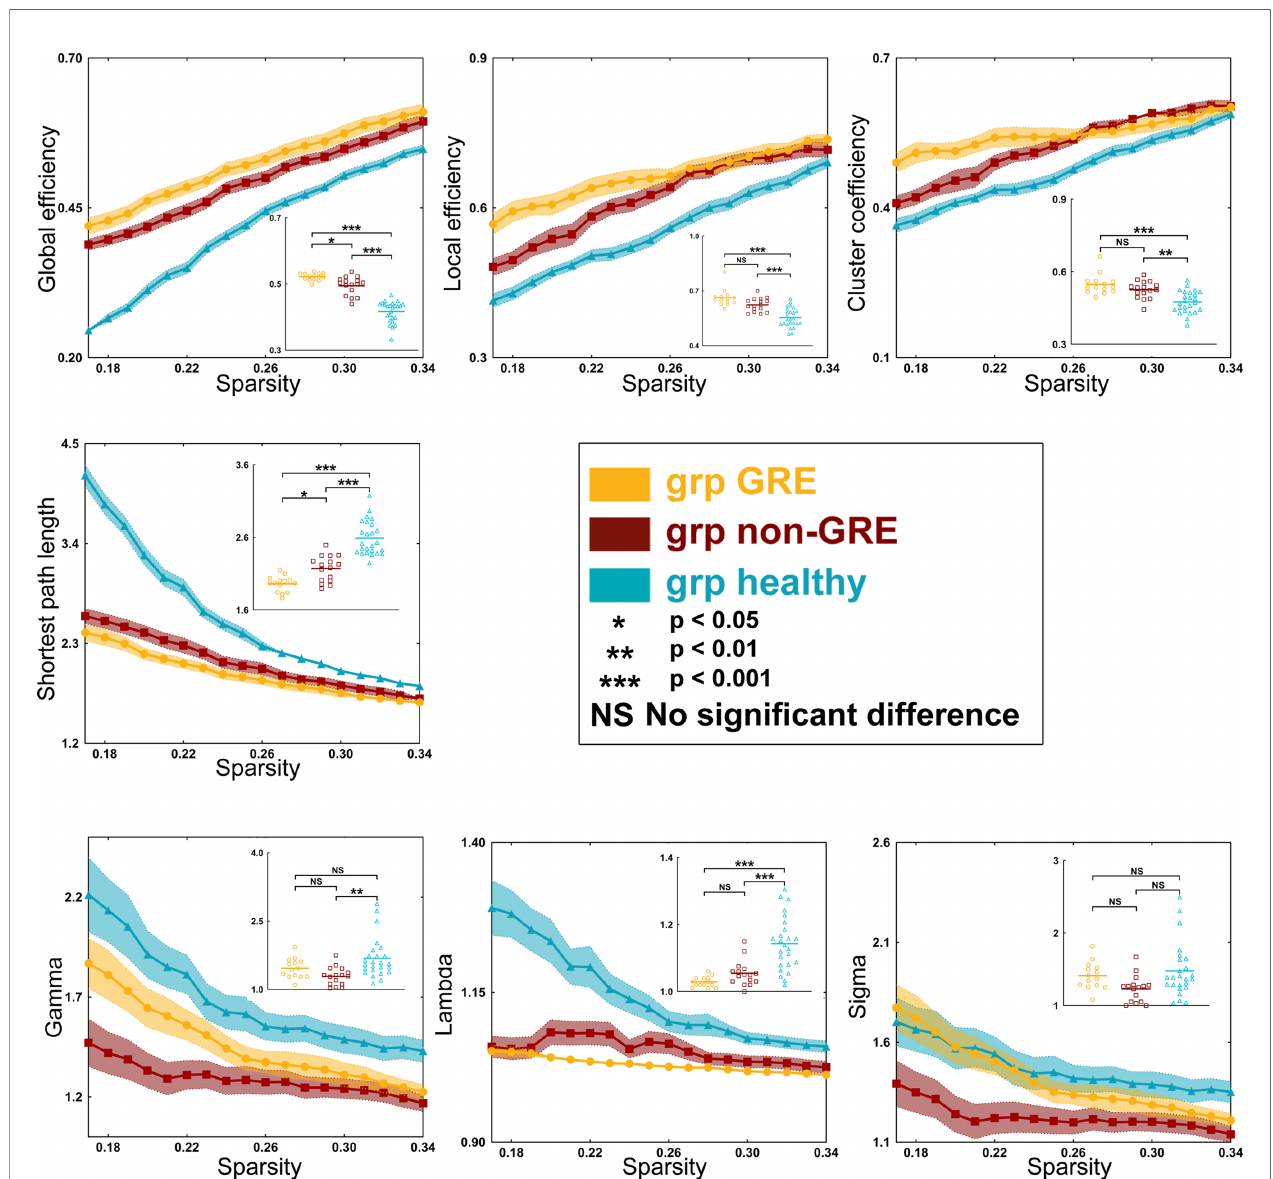
FIGURE 5 | Results of alterations in topological properties gliomas grew in the right prefrontal lobe. Each property was analyzed with one-way ANOVA test and post-hoc test with least signi fi cant difference correction. The grp GRE (n = 14), group of patients with glioma-related epilepsy. The grp non-GRE (n = 16), group of patients without glioma-related epilepsy. The grp healthy (n = 25), group of healthy